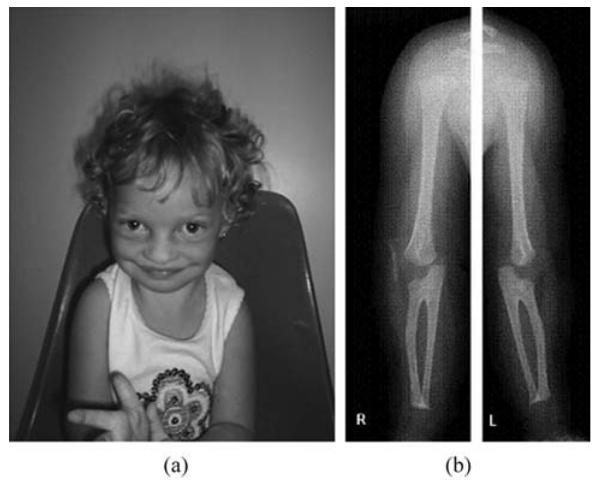
Figure 1 - Deletion 4p and duplication 8p revealed by array-CGH (A and C), and confirmed by FISH (B and D): The deleted (A) and duplicated (B) clones are shown in the array profiles and corresponding chromosome idiograms. After FISH a derivative chromosome 4 was identified, show- ing deletion of clone GS-36-21 (B), and addition of clone GS-580-L5 (D). Arrows point to der